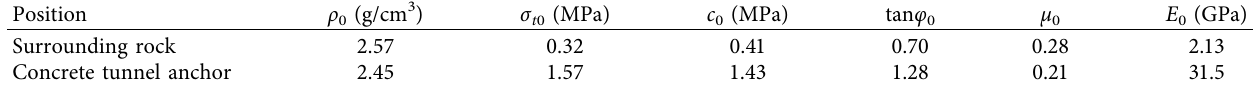
Table 3: Input parameters of surrounding rocks and concrete tunnel anchor.